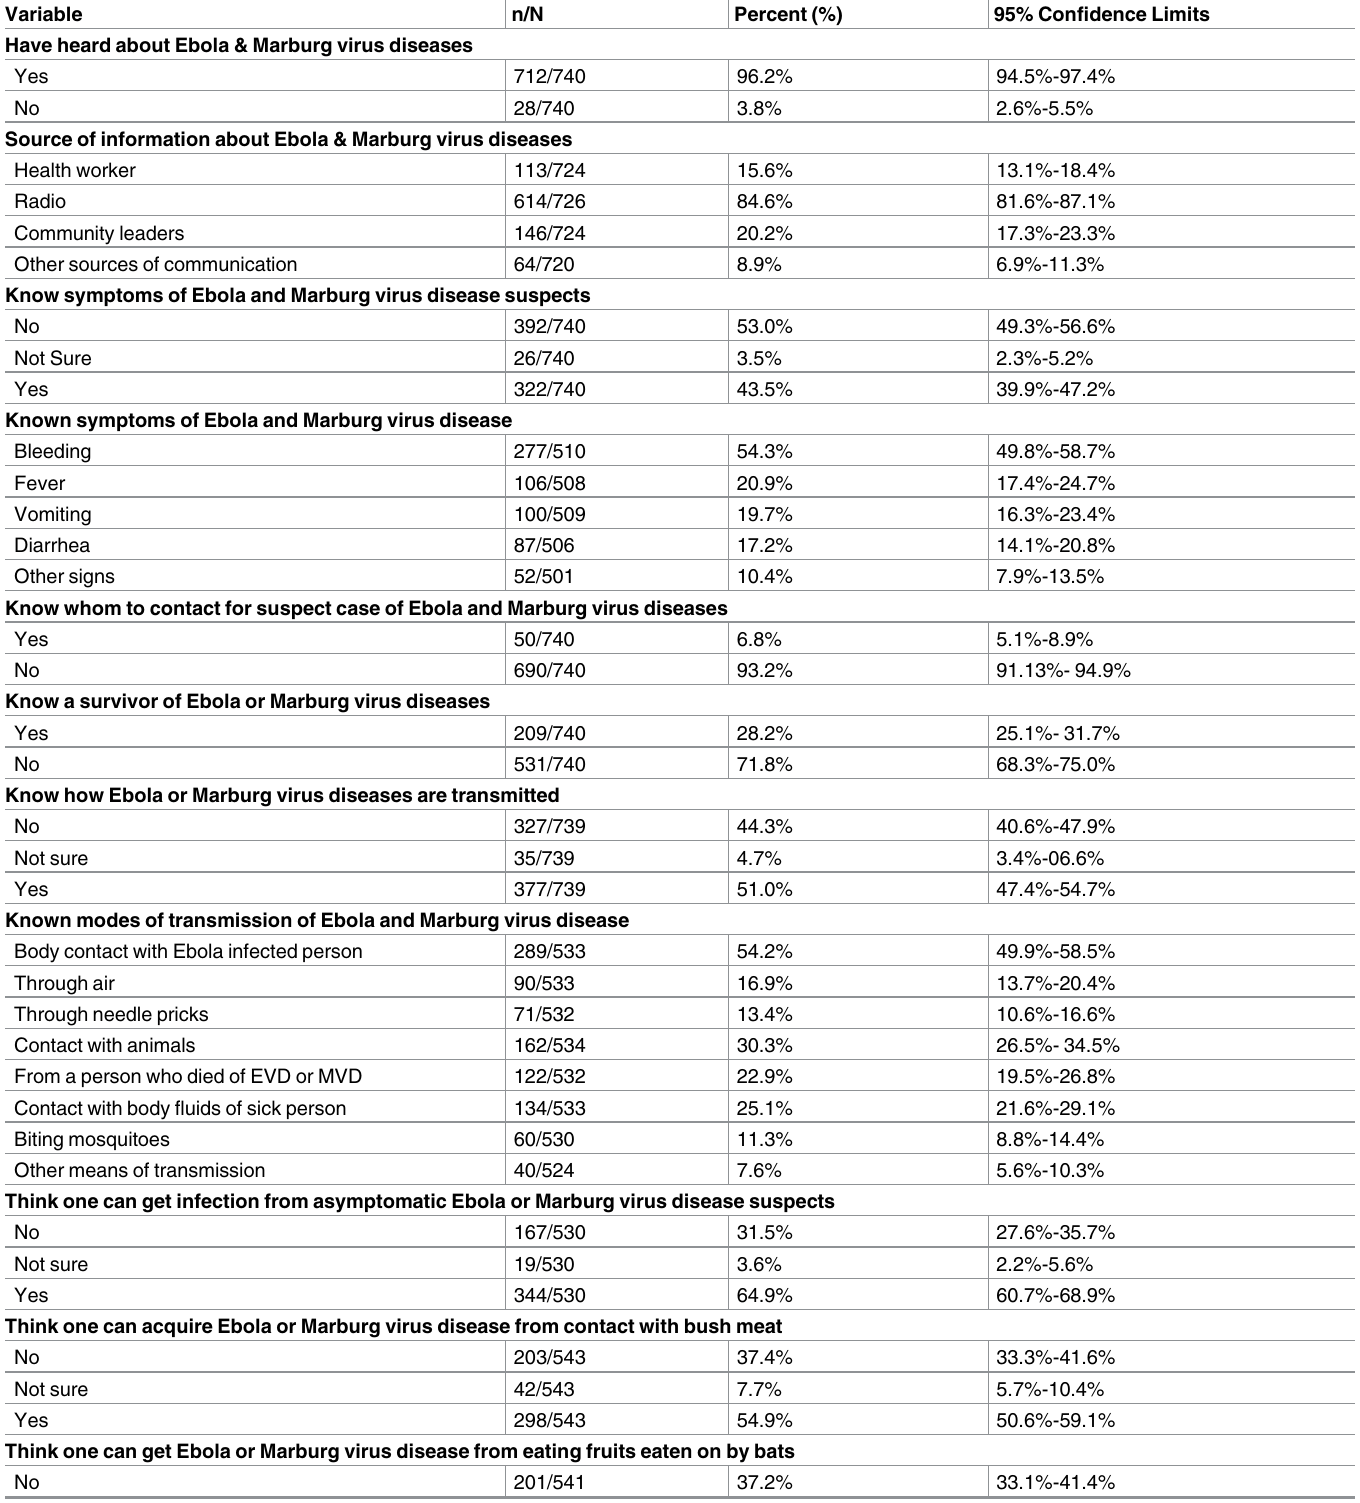
Table 1. Knowledge on Ebola and Marburg viral diseasesand their modes of